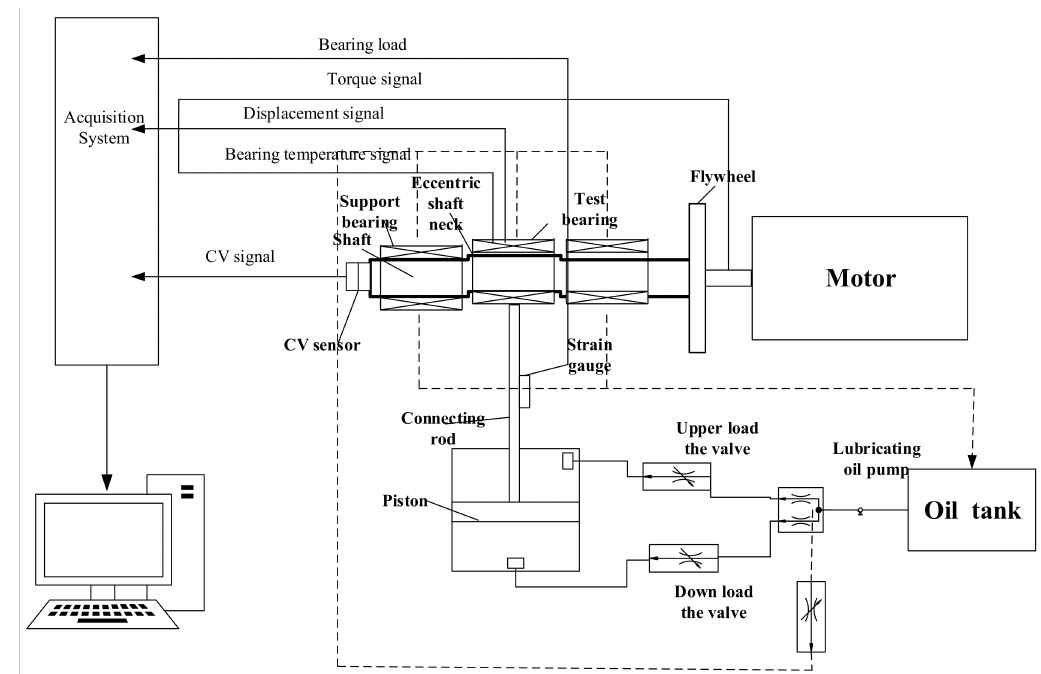
Figure 1. Bearing fatigue test bench testing system schematic.